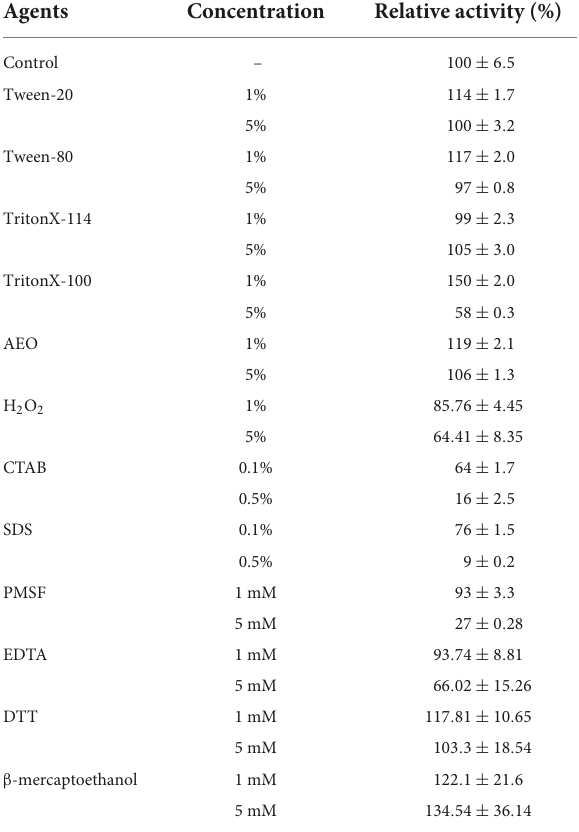
TABLE 4 The effect of chemical reagents on the activity of prot